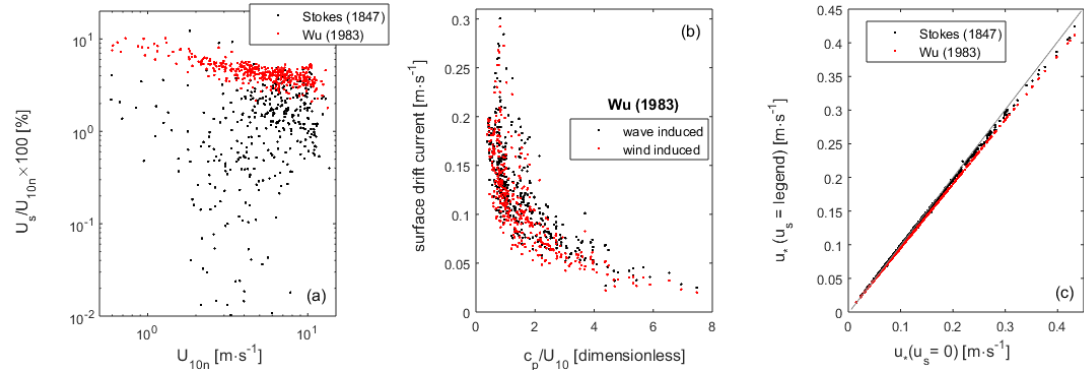
Figure 2. Surface velocity (u s ) and its effect on the estimation of u * . ( a ) The u s is estimated from Stokes’ [117] and Wu’s [62,114] algorithms, shown as a percentage of the wind velocity at a 10 m height under atmospherically neutral conditions (u 10n ). ( b ) The wind- and wave-induced drift currents estimated from Wu [62,114] are related with the wave age (c p /u 10 ), where c p is the celerity of peak waves. ( c ) The resulting u * is compared with the estimated neglecting the u s .